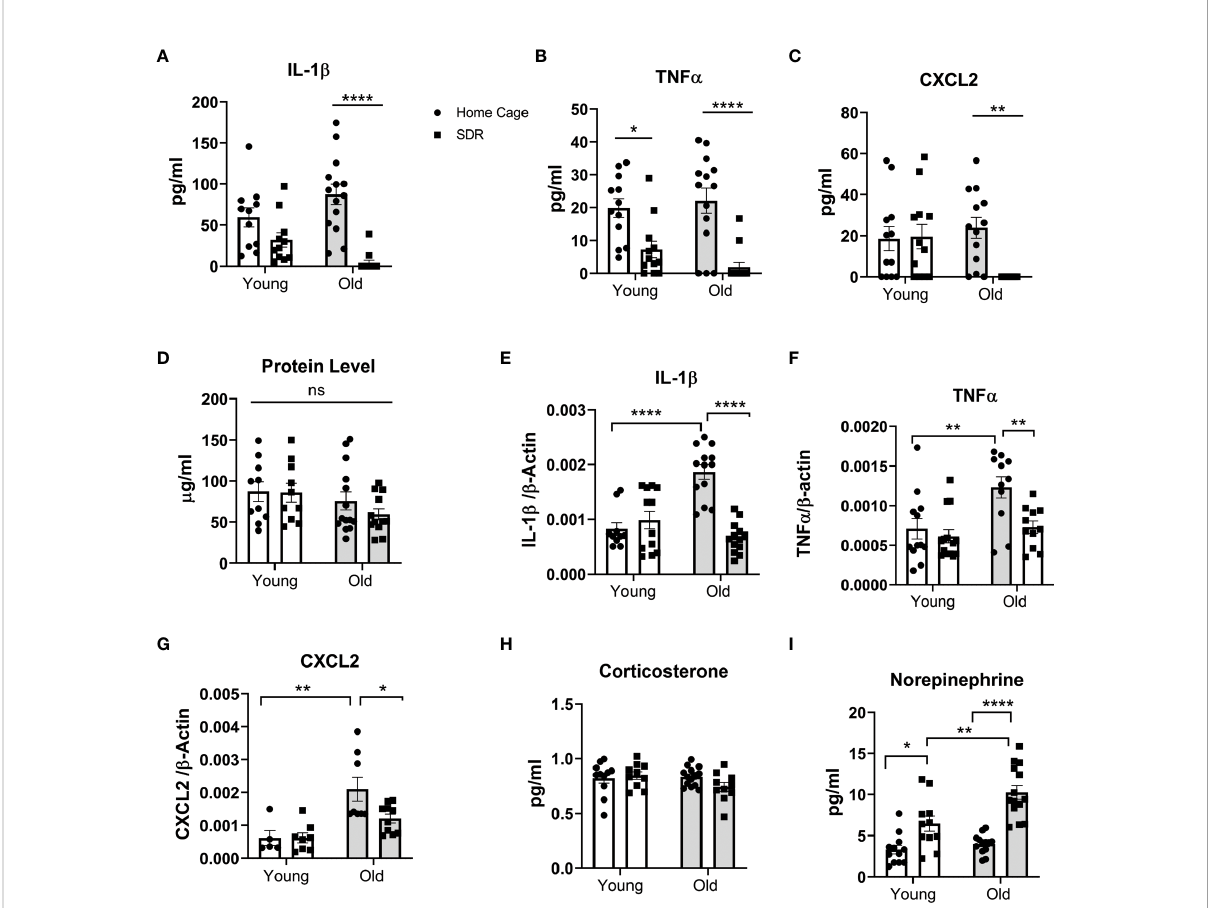
FIGURE 2 SDR in old mice suppresses cytokine levels in BAL fl uid and basal mRNA levels in alveolar macrophages. BAL fl uid and alveolar macrophages were isolated from individual young (3 months) and old (18 months) Home Cage mice and mice subjected to 6 cycles of SDR. (A – C) Cytokine levels in BAL fl uid determined by ELISA. Protein levels in BAL fl uid were determined by Bio-RAD protein assay (D) . (E – G) Basal cytokine mRNA expression in AMs. RNA was isolated from individual mice without culture and mRNA levels determined by qRT-PCR. Expression levels were normalized to b -actin mRNA. Protein levels in BAL fl uid were determined by Bio-RAD protein assay. (H, I) Corticosterone and Norepinephrine levels in BAL fl uid determined by ELISA. Each symbol represents individual mice. N=9-15 mice/group. Data are shown as mean ± SE. Statistical analysis was performed by one-way ANOVA with Tukey multiple-comparisons post hoc test. ns, non signi fi cant. * p < 0.05, ** p < 0.01, **** p <